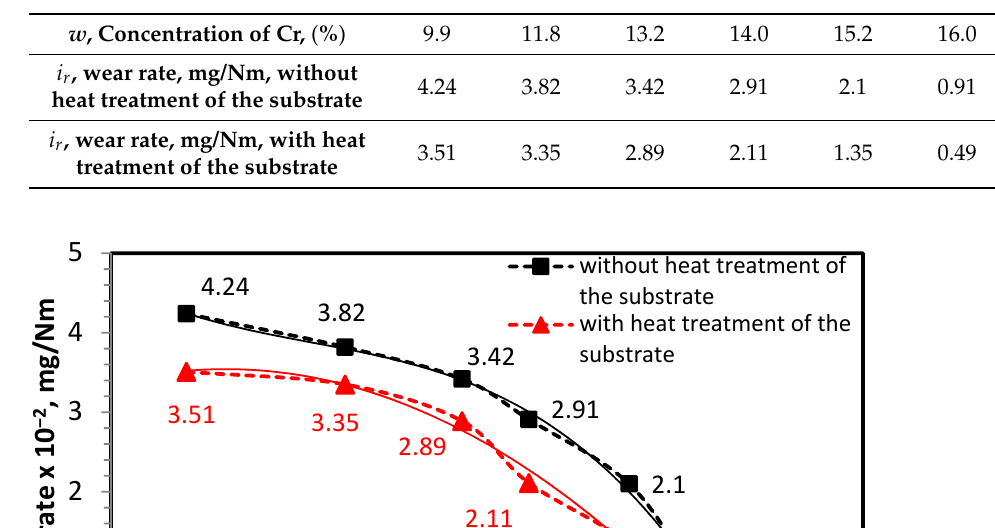
Figure 16. Analytical dependences of the wear rate on the chromium concentration for coatings without heat treatment, 𝑖 (cid:3045) (cid:4666)𝑤(cid:4667) = −0.00599819𝑤 (cid:2871) + 0.099501902𝑤 (cid:2870) . The Adjusted R Square is 0.745894827 and shows that 74.58% of the variance of the intensity of wear is predictable from chosen factors ( w 3 , w 2 ) which are adequately included in the model. The value of the significance F with significance level 0.05 is 0.00012 < 0.05 (0.012% < 5%), i.e. the results are reliable (statistically significant) and the model is ade- quate. p -values of the coefficients of the regression equations with level of significance 0.05 are smaller than 0.000032, i.e., they are smaller than 0.05, which means that the coef- ficients are statistically significant, and the adequacy of the model is confirmed.